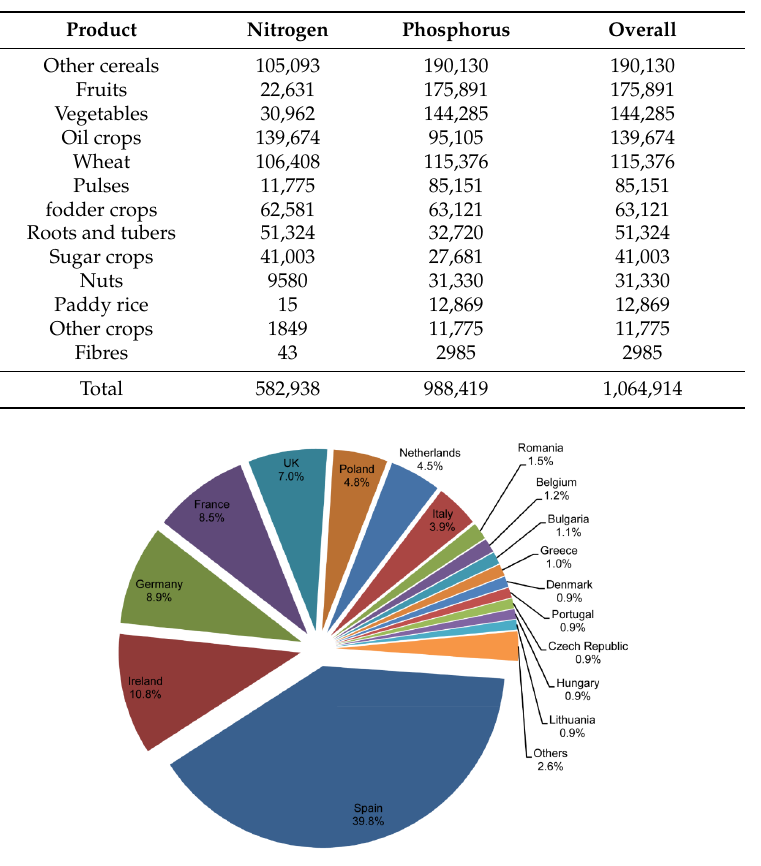
Figure 2. Contribution of different countries to the overall GWF of EU-27 related to production. Period: 2007.